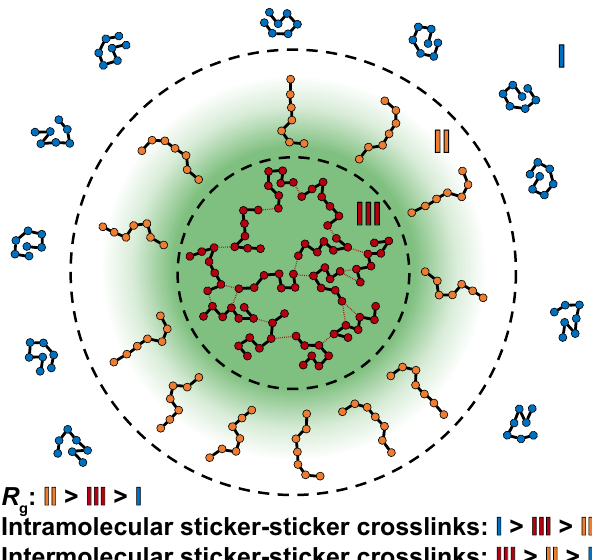
Fig. 6 | Molecular properties of interfaces are distinct from dilute and dense phases. Diagram summarizing our fi ndings concerning condensate organization. Region I is the dilute phase, Region II is the condensate interface, and Region III is the interiorof a condensate.Region I is characterized byrelatively compactchains that form few intermolecular contacts. Region II is characterized by relatively expanded chains that are oriented perpendicular to the interface and form the fewest number of total sticker crosslinks. Region III is characterized by chains that are less compact than those in Region I and less expanded than those in Region II. These chains form numerous intermolecular sticker crosslinks, giving rise to a small-world percolated